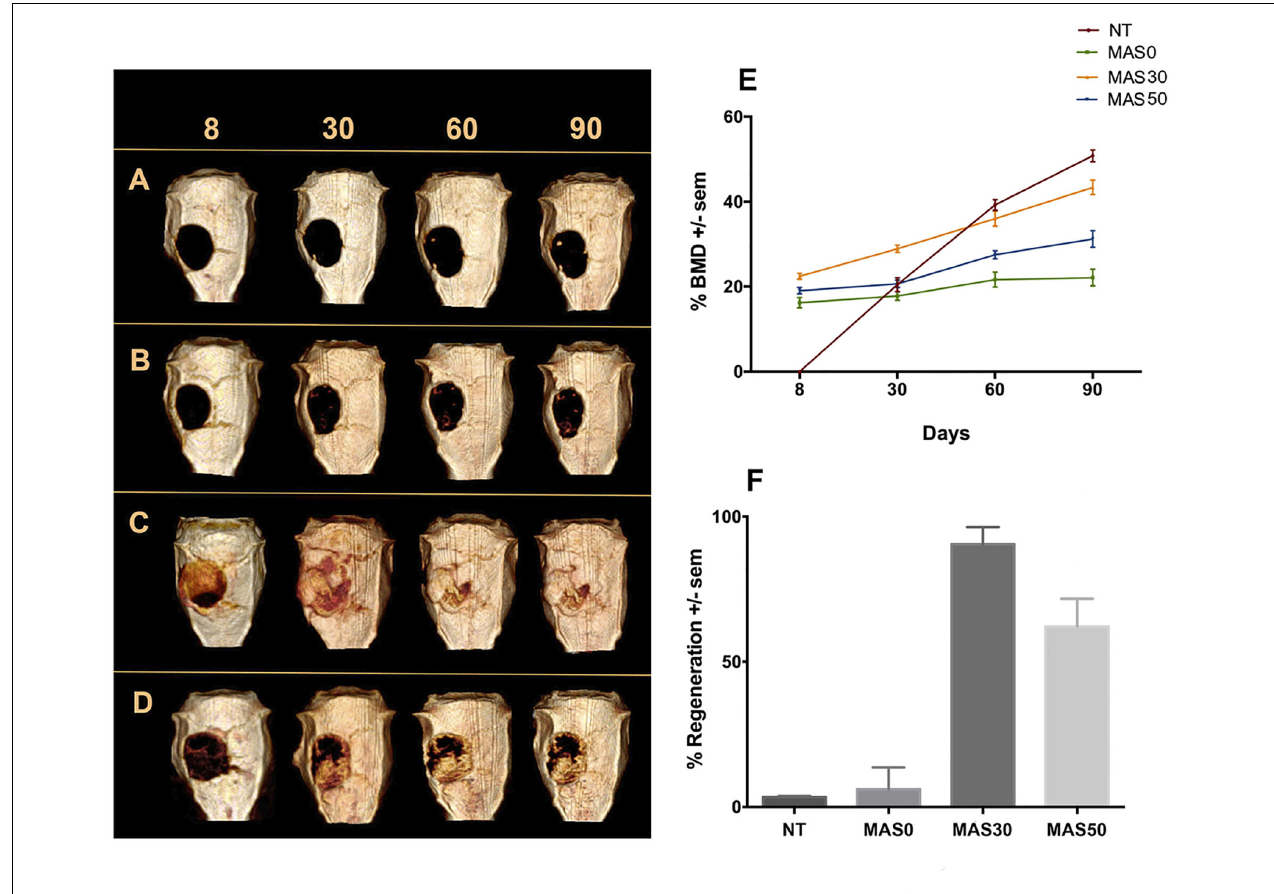
FIGURE 3 | (A) Sequence of micro-CT images of sponges after 8, 30, 60, and 90 days in the in vivo calvaria defect model. (A) No treatment (NT), (B) MAS0, (C) MAS30, and (D) MAS50. (E) Measurement of bone mineral density (BMD) after 8, 30, 60, and 90 days in the calvaria defect model. (F) Percentage of in vivo total bone regeneration after 90 days in the calvaria defect